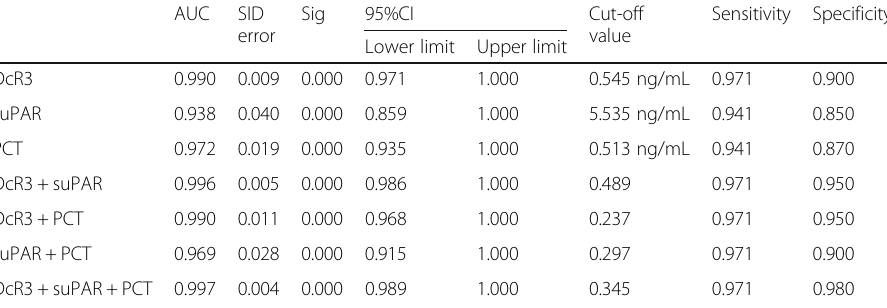
Table 3 Receiver operating characteristic analysis of DcR3, suPAR and PCT in control and sepsis